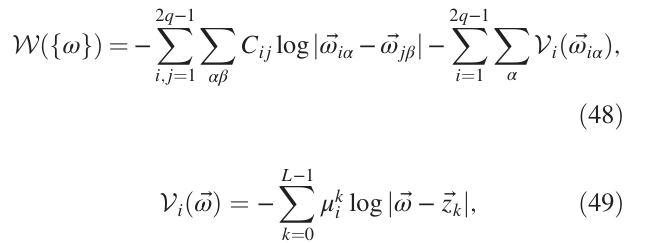
FIG. 2. Example one-dimensional potential V Eq. (49) with three different values of z